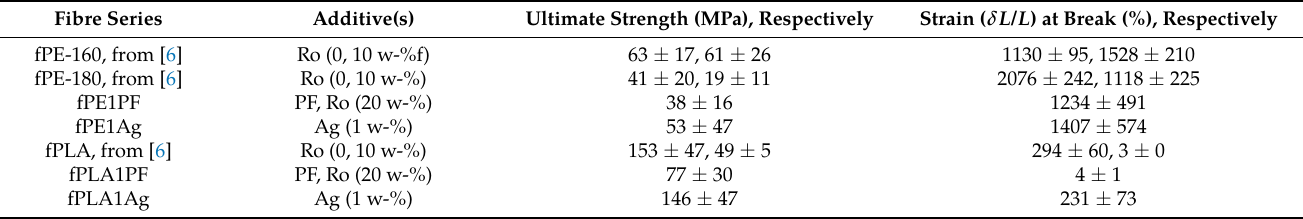
Figure 2. Characteristics of the Ag nanoparticles: ( a ) SEM imaging of particle size variation and particle morphology; ( b ) the EDS spectrum measured on Ag nanoparticles and the elemental distribution. Table 5. Mechanical properties of fibres and the determined mechanical properties per additive concentration, respectively. Fibre